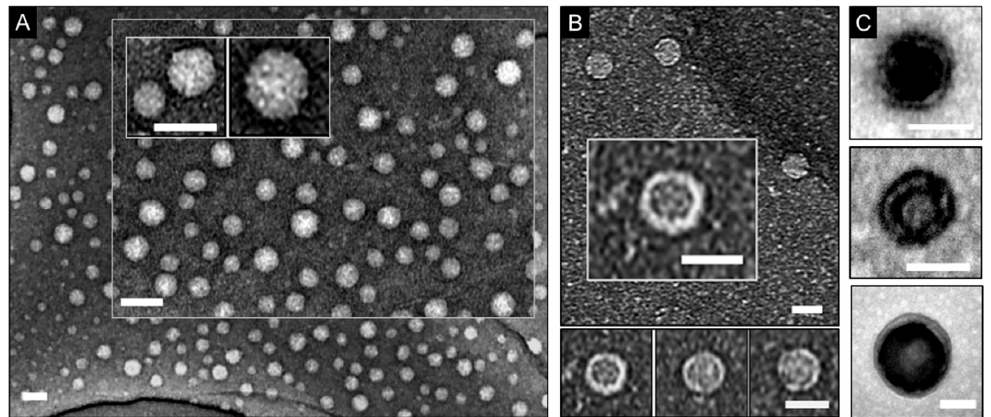
Figure 1. Contrast staining in imaging spherical, shell ‐ like protein morphologies. Electron micrographs of model 1 ( A ), model 2 ( B ), and ( C ) model 1 on copper grids coated with holey carbon, and graphene oxide films ( A , B ) and carbon film ( C ). Scale bars are 50 nm ( A, C ) and 30 nm ( B ). Staining conditions: Nano ‐ W TM (aq. 2%, w/v) for ( A , B ) and ( C , top and bottom), and uranyl acetate (aq. 2%, w/v) for ( C , middle).